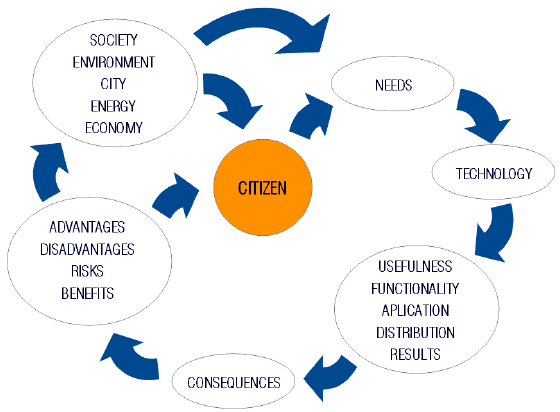
Figure 3. Circular flow diagram between the needs and consequences of technological application, based on social and individual